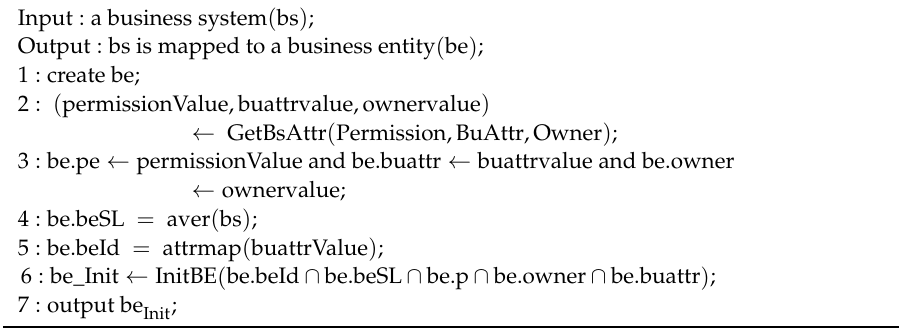
Algorithm 1: Initial initialization algorithm of business entity